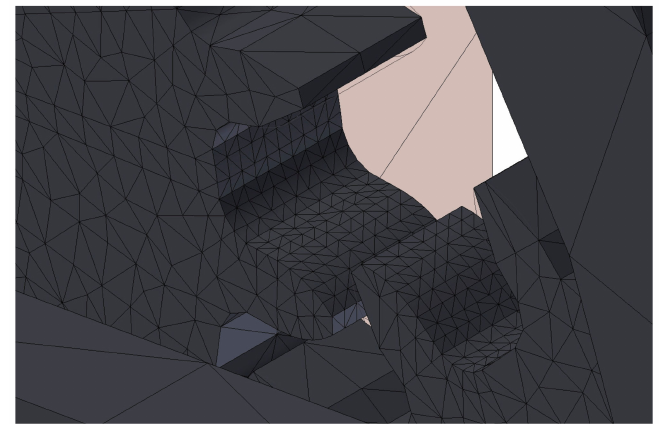
Figure 15. Refinement of the mesh in the teeth of the